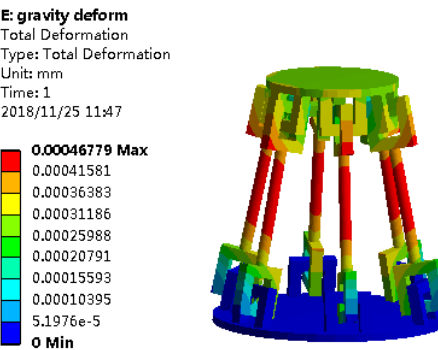
Figure 8. The load nephograms of the CPM with bearing gravity.